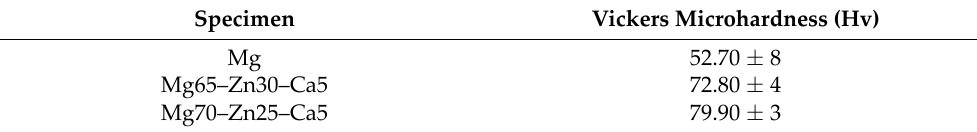
Table 5. Microhardness test.